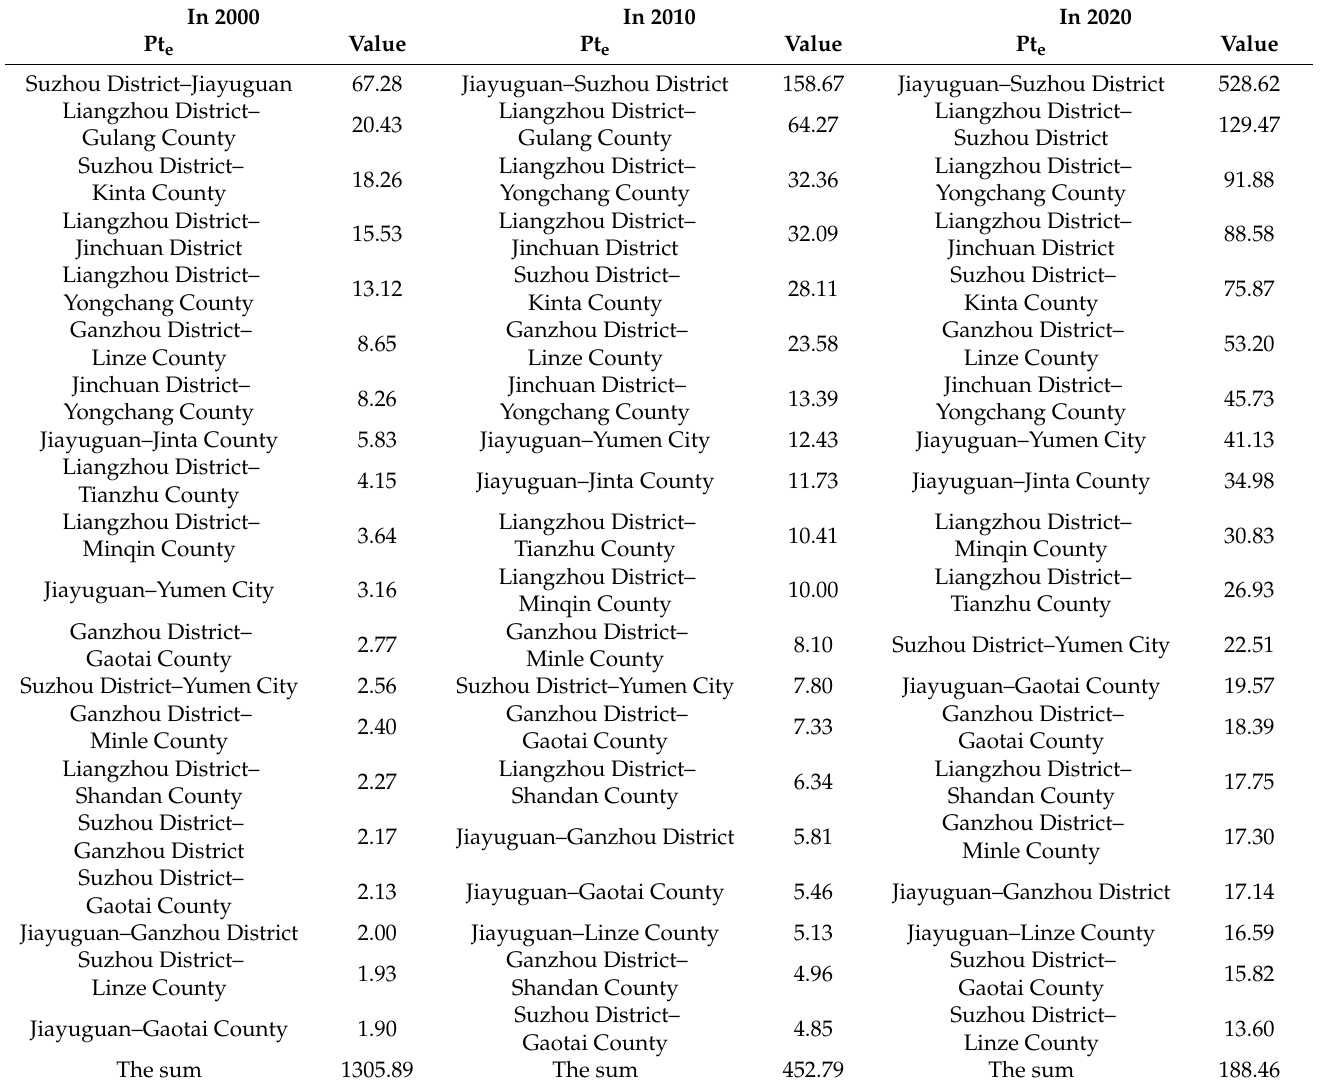
Table 5. The top 20 pairs of two-party relationships in the economic connection strength of the Hexi Corridor urban